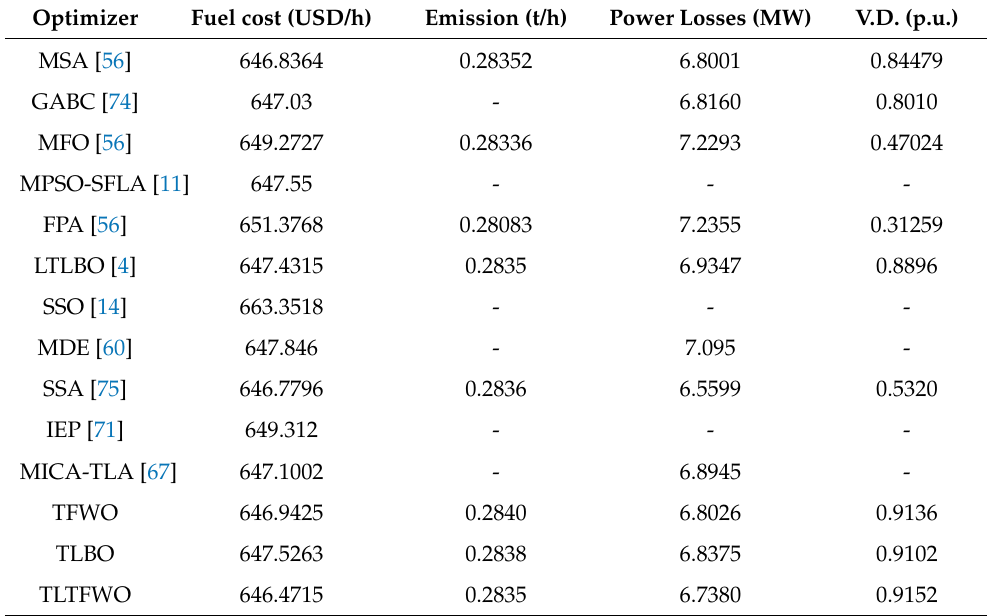
Table 5. The optimal results found by different algorithms in Case